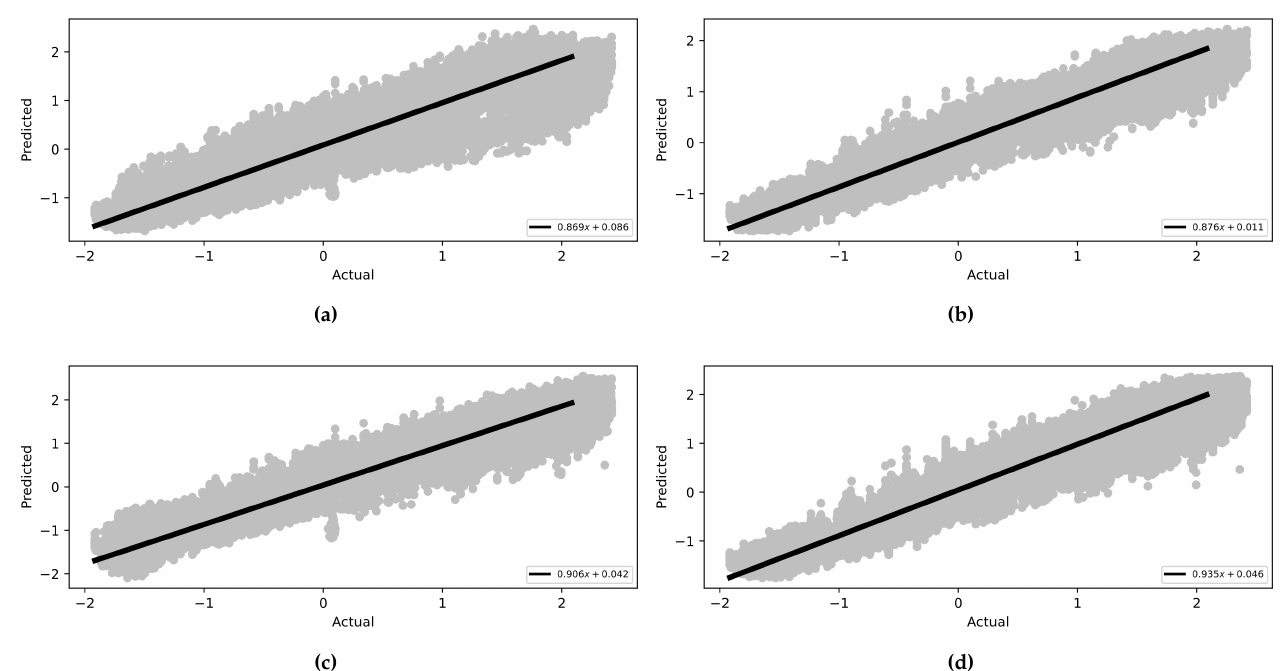
Figure 13. Linear correlation between the actual values (x-axis) and the predicted values (y-axis) for foot angular velocity of the 5 th subject. ( a ) MLP - no CGP.( b ) MLP - CGP. ( c ) CNN - no CGP. ( a ) CNN - CGP.